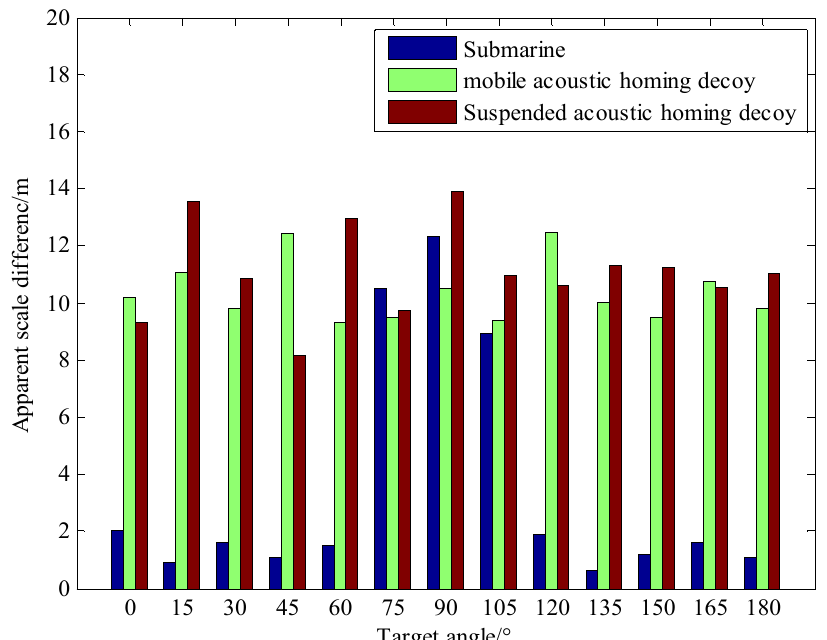
Figure 16. The apparent scale difference of different ship angles.